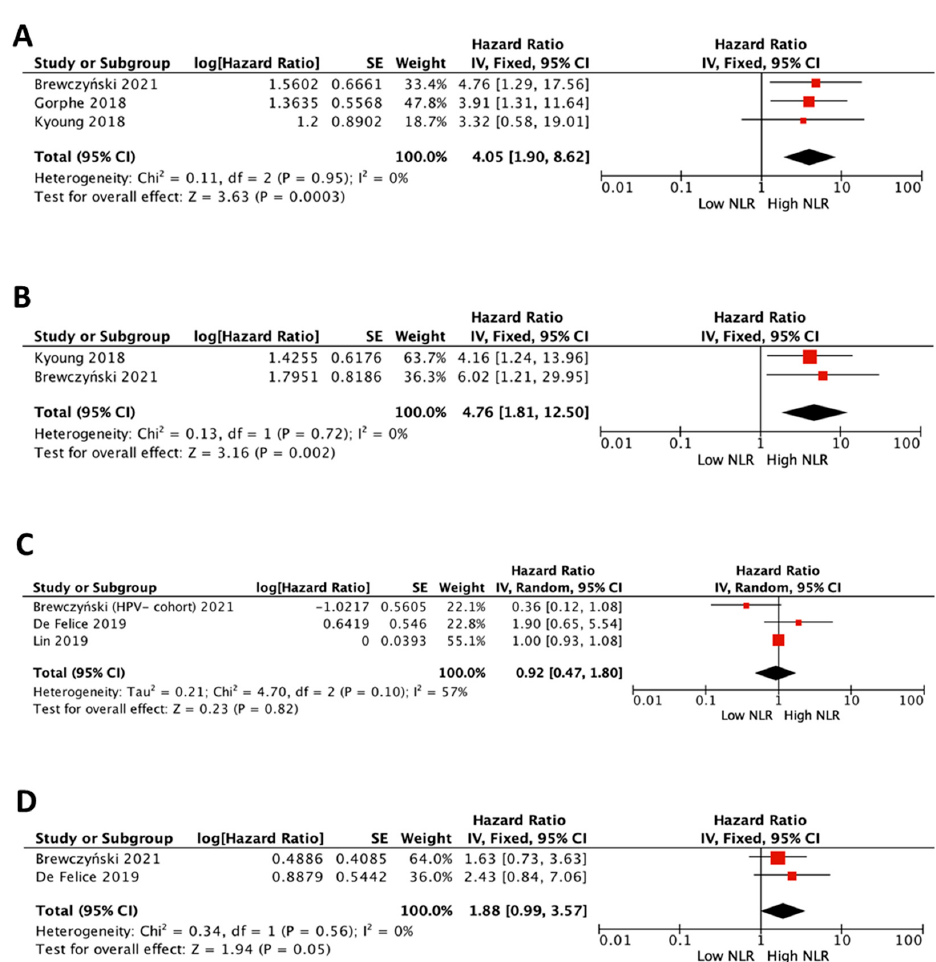
Figure 3. Forest plots of impact of NLR in “HPV+ patients” on overall survival ( A ) and disease-free survival ( B ), and of the impact of NLR in “HPV- patients” on overall survival ( C ) and disease-free survival ( D ). [14, 15, 18, 20, 25].